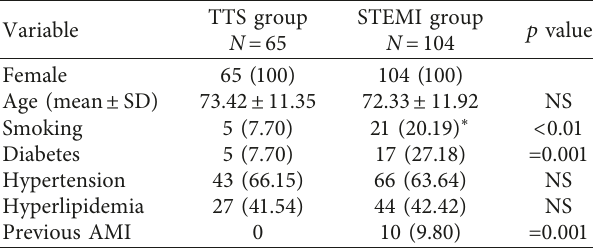
AMI: acutemyocardial infarction;CABG:coronaryartery bypass graft;PCI: percutaneous coronary intervention; NS: not significant. ∗ Anamnestic data missing in eight (12.50%)